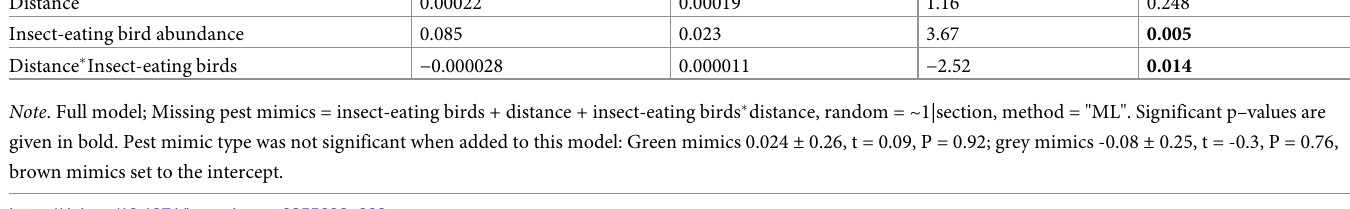
Table 2. Model 1B. The relationship between number of missing pest mimics and insect-eating bird abundance, distance to a forest fragment. The model also tests how the relationship between missing pest mimics and bird abundance depends on distance to a forest fragment. Variables